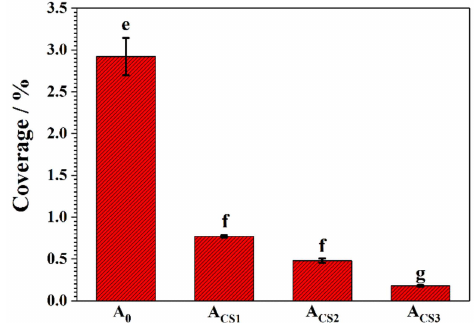
Figure 9. Coverage of bacteria attached to A 0 , A CS1 , A CS2, and A CS3 after 24 h of exposure in a PBS medium suspended with 10 6 cfu mL − 1 E. coli. Means with letters e, f and g denoting significant di ff erences ( p <